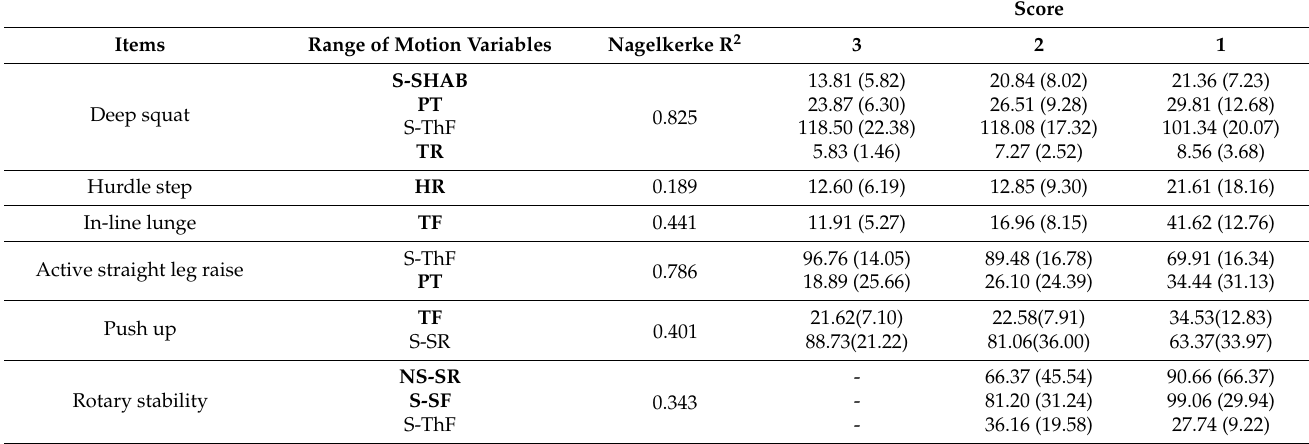
Bold font indicates that the regression model coefficient is negative, which is negatively correlated with the